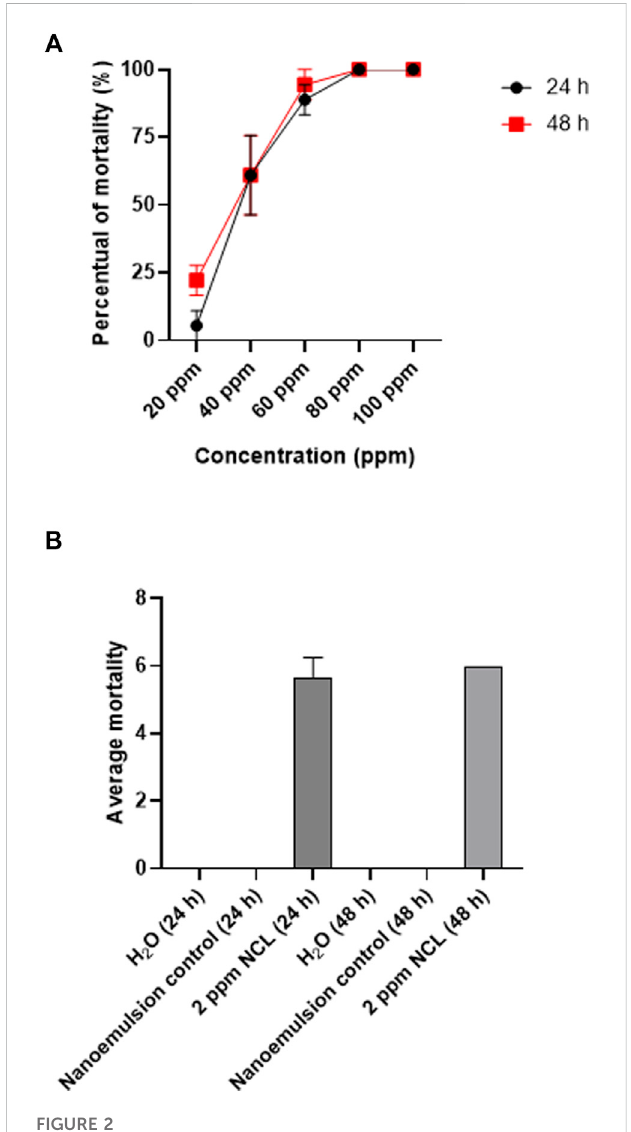
FIGURE 2 (A) Molluskicidal effect of the Neomitranthes obscura nanoemulsion on Biomphalaria glabrata adults exposed for 48 h. (B) Controls. These tests were repeated three times in three different periods ( n = 9). R2: 0.9994, p -value: < 0.0001.